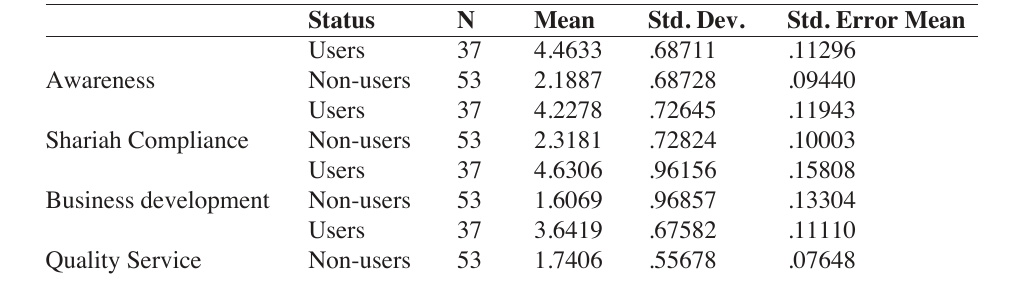
Table 4: Descriptive Statistics of Users and Non-users